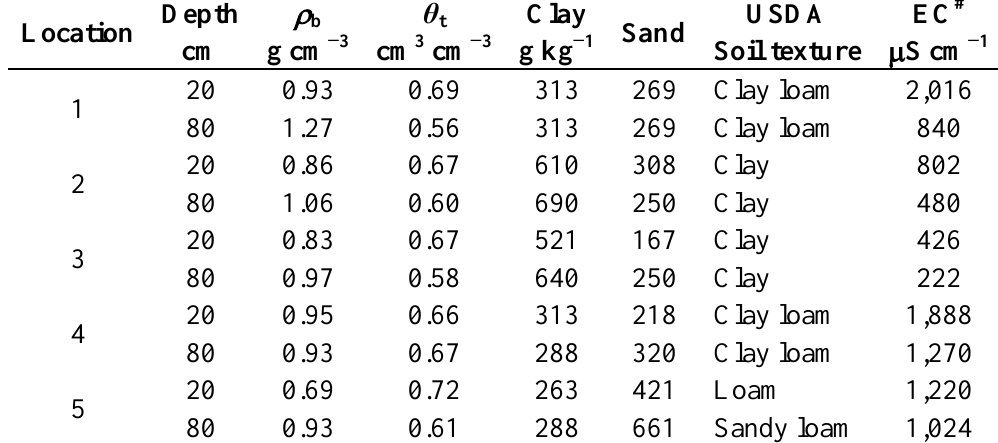
Table 2. The USDA soil classification, particle size distribution, bulk density (  porosity ( θ ), and the values of electrical conductivity (EC) of the soil samples collected t from 20 and 80 cm depths at the five monitoring locations in the Upper Mākaha Valley